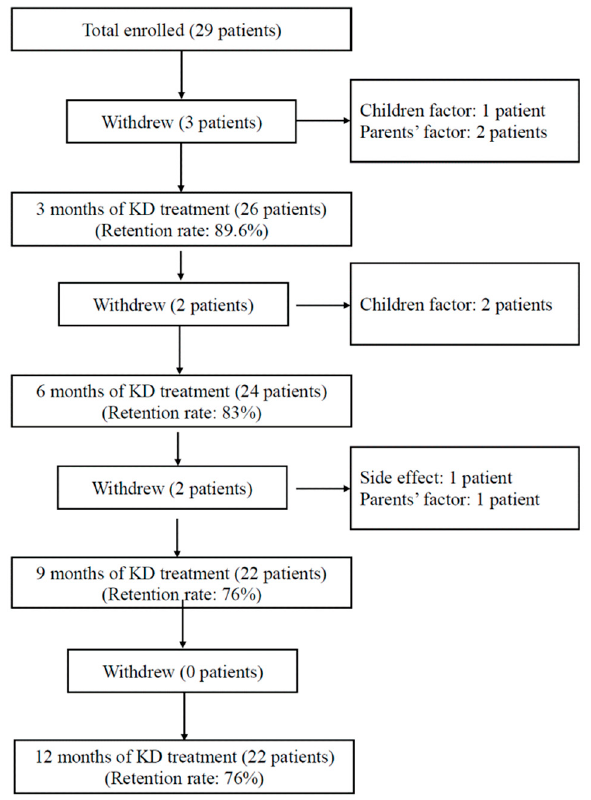
Figure 1. Flow chart showing the study protocol.